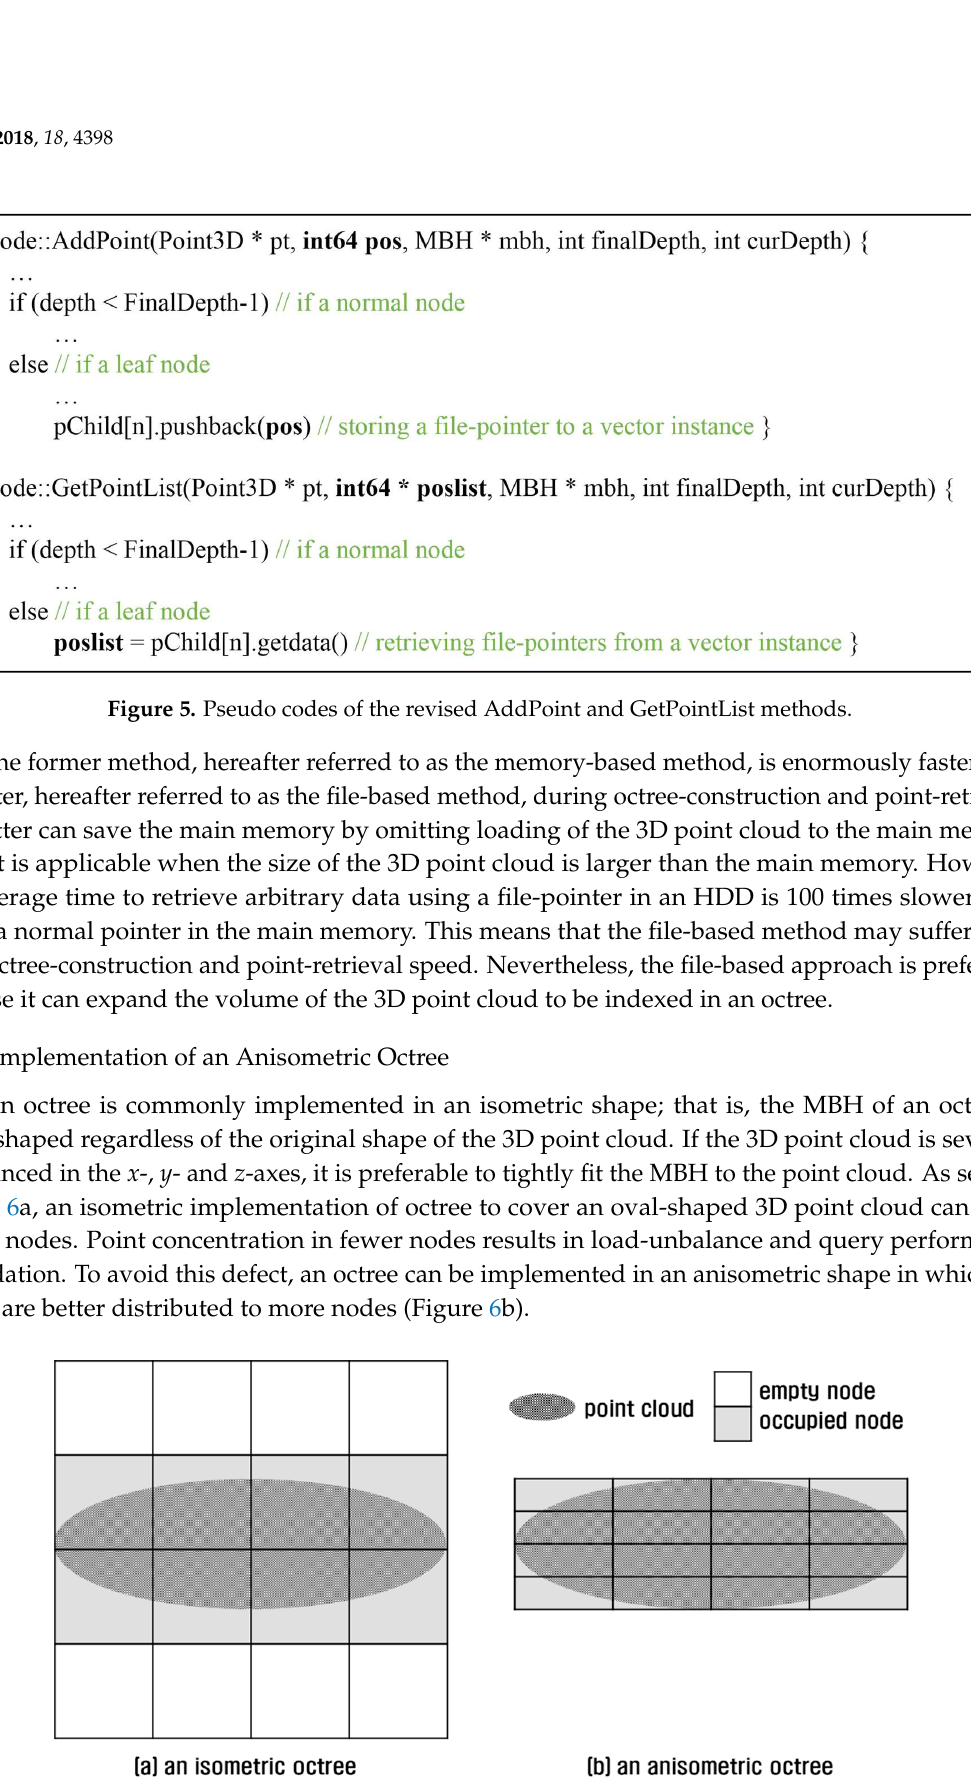
Figure 6. Comparison of octrees: ( a ) an isometric octree; ( b ) an anisometric octree.